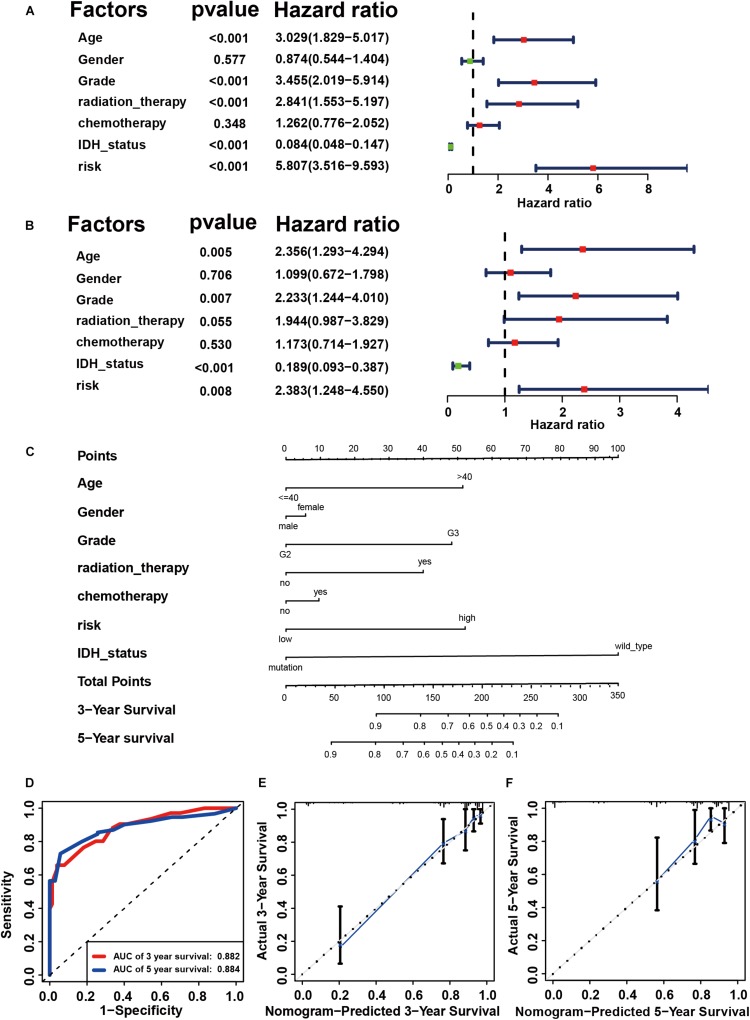
Construction of prognostic signature in primary LGG from TCGA. Univariate (A) and multivariable Cox proportion hazard regression for OS (B) of primary LGG in training group. (C) A nomogram consisting of risk score and other clinical indicators for predicting 3-, and 5-year OS of primary LGG. (D) Time-dependent ROC for 3-, and 5-year OS predictions for the nomogram compared with actual observations. Calibration plot of nomogram for predicting probabilities of 3-year (E), and 5-year (F) overall survival of patients. Blue line indicates actual survival.